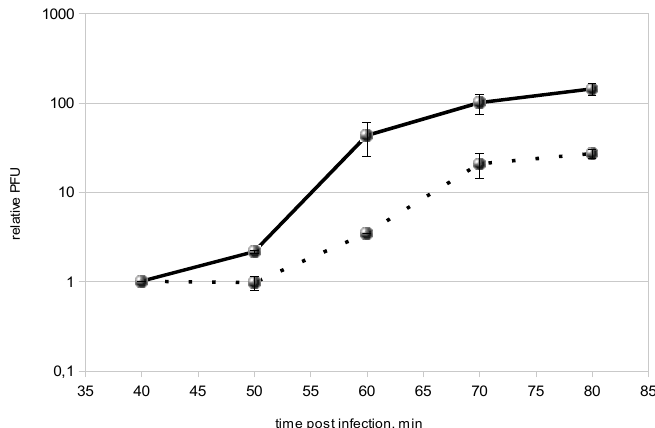
Figure 5. One-step growth curves of phages T5 wt and T5 amT5.026 . The E. coli JF238 culture was infected with wild-type and T5 amT5.026 phages, and aliquots were taken at di ff erent minutes after infection and plated in soft agar to determine the number of plaque-forming units (PFU). The ordinate shows the ratio of PFUs at indicated time points of infection to the number of PFUs at 40 min post-infection (relative amount of PFUs); the number of PFUs remains constant up to 40 min. The experiment was repeated three times. Means and standard deviations from the mean are shown. Continuous and dashed lines show the change in the relative amounts of PFU in the course of infection by phages T5wt and T5 amT5.026 , respectively.